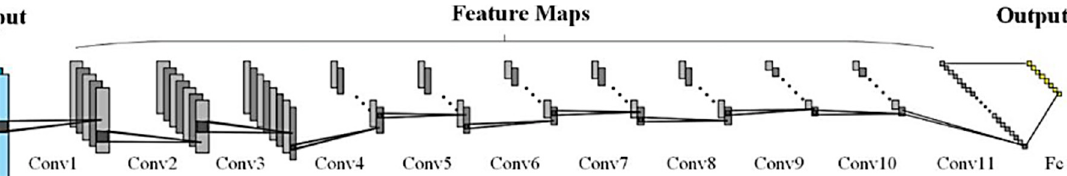
Figure 1. Flowchart of body dimensions measurement of Qinchuan cattle with transfer learning from LiDAR sensor.